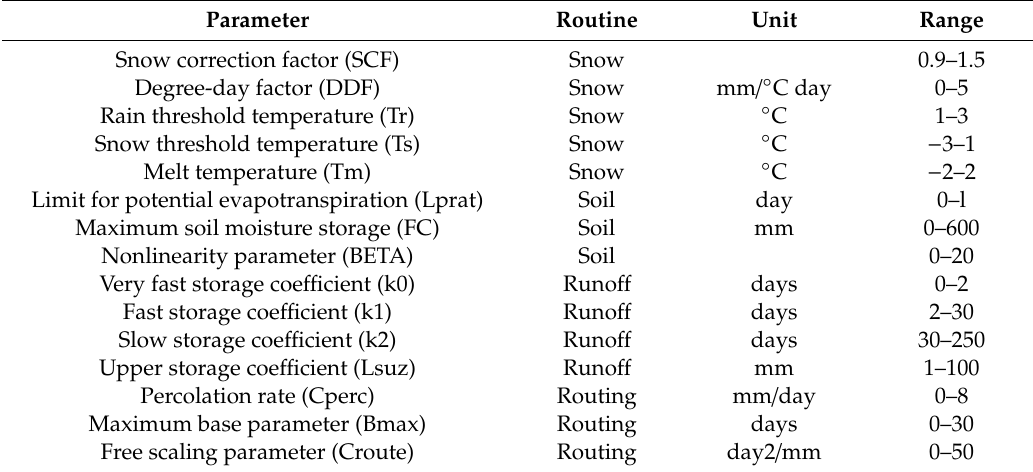
Table2. 15TUWmodelparametersaccordingtotheroutinesandtheircalibrationranges. Thecalibration ranges were taken from the literature